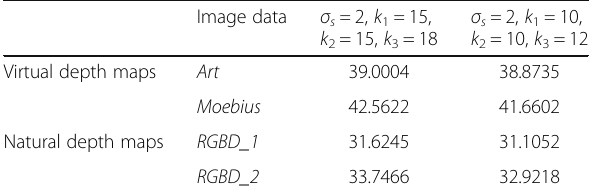
Table 2 PSNR comparisons with sensitive of parameters on Middlebury and RGBD dataset Image